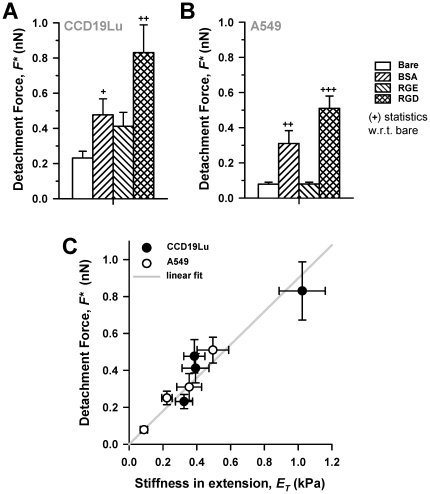
RGD-induced strengthening of lung cell-tip adhesion.(A, B) F* data obtained on (A) CCD-19Lu fibroblasts and on (B) A549 cells. Bar filling patterns shown on the right apply to plots A–B. (C) Plot of F* vs ET average data collected on all cell types with all tip coatings. Solid line corresponds to a least-squares fitting of a linear polynomial to the data. +P<0.05, ++P<0.01 and +++P<0.005 were determined by unpaired Student's t-test w.r.t. bare.